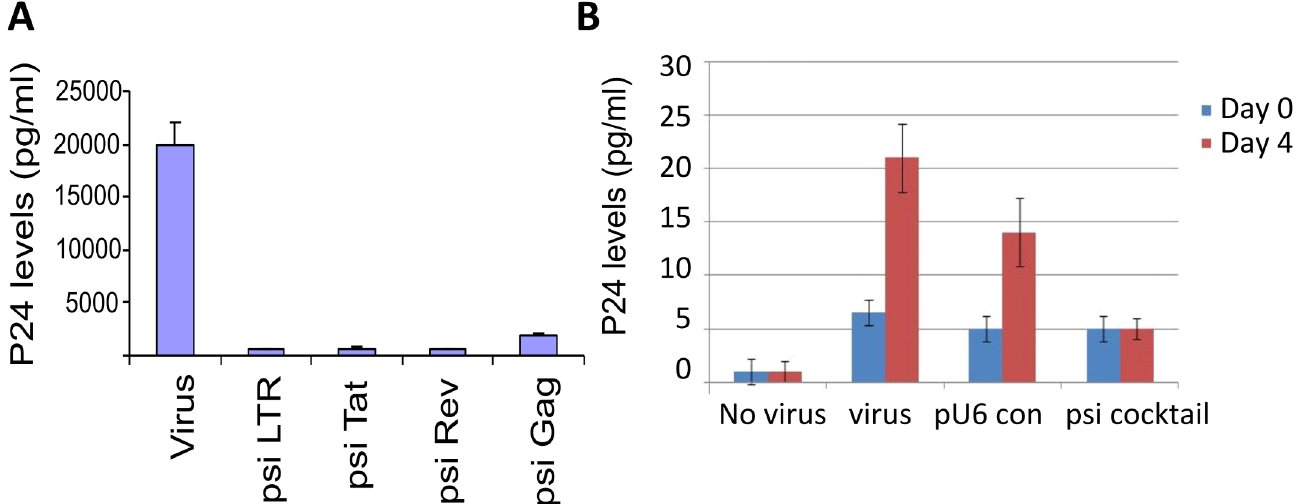
Fig 2. Inhibition of HIV-1 replication by siRNAs targeting HIV-1 genes. HEK293 cells grown in 96-well plates were co-transfected with 1 μ g of each vector-driven siRNA (psiLTR, psiTat, psiRev, psiGag) or pU6 vector control, along with 1 μ g of HIV89.6 proviral DNA using the Lipofectamine reagent. The viral supernatant was collected 48 h after transfection and the p24 levels were measured by HIV-1 p24 ELISA and normalized against the negative control. The experiment was repeated at least twice and values represent mean ± SEM. (B) Human PBMCs were cultured in 12-well plates, incubated with 1 μ g /1 million cells of psicocktail (psiTat + psiRev + psiGag + psiLTR) CNs or pU6 vector control-CNs or naked CNs for 24 h and then infected with HIV89.6 (pg/ml) for 2 – 3 h. After infection, the cells were washed with PBS and fresh medium was added. Culture supernatants in duplicate were assayed for p24 concentration (pg/ml) by p24 ELISA.